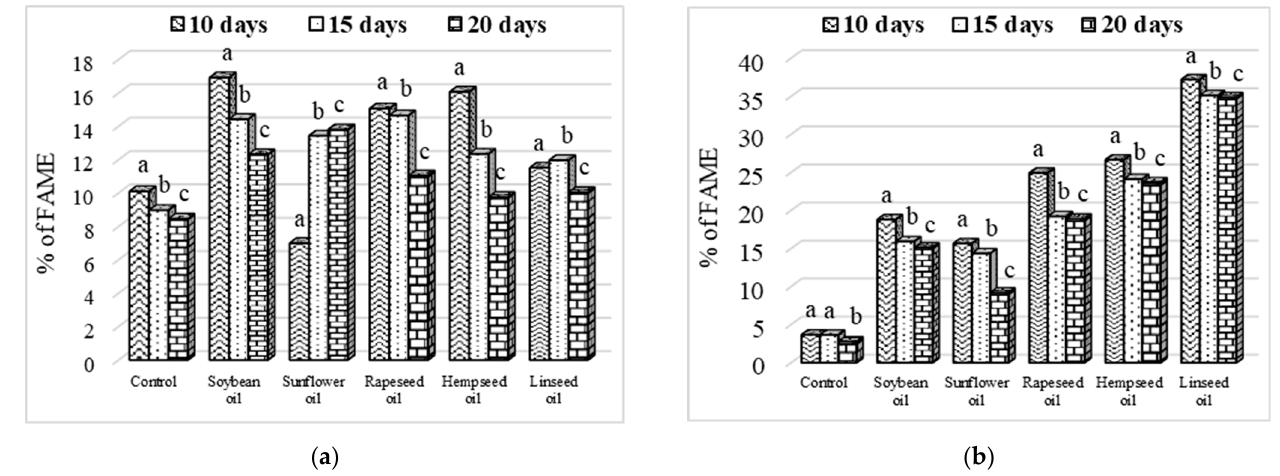
Figure 4. Evolution of monounsaturated ( a ) and polyunsaturated ( b ) fatty acids according to larvae age. Different letters (a–c) above means indicate intragroup significant differences at p < 0.05.